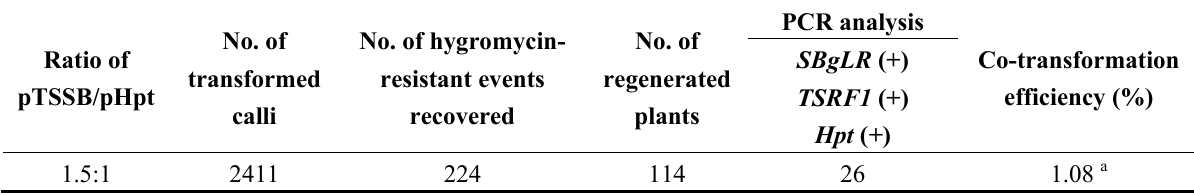
Co-transformation efficiency (%)